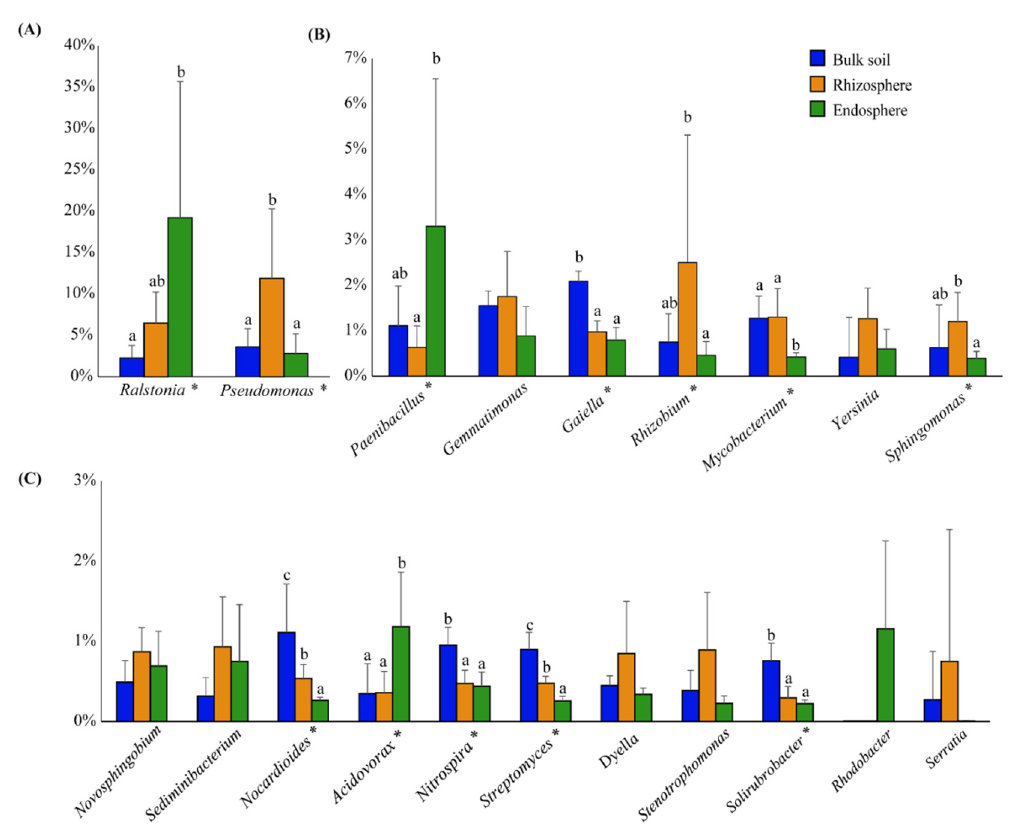
Figure 2. The relative abundance of bacterial genera associated with the bulk soil, rhizosphere and endosphere of Tropaeolum majus determined through 16S rRNA amplicon metagenomic sequencing. Asterisks next to the genus name indicate that there is a significant difference. Different letters above error bars indicate which sampled site showed significant differences (Tukey’s test or Mann–Whitney U test, p < 0.05). ( A ) Up to 40% relative abundance, ( B ) up to 7% relative abundance and ( C ) up to 3% relative abundance.